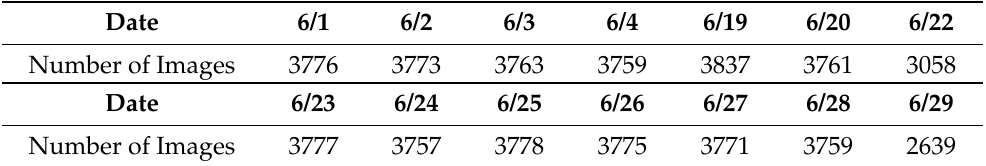
Table 2. Number of images selected each